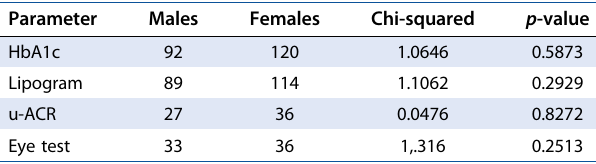
Table 3: Relationship between sex and tests performed Parameter